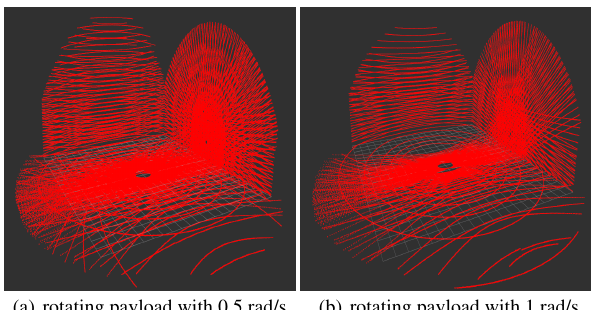
Figure 11. Varying the payload rotation speed in a static drone mode